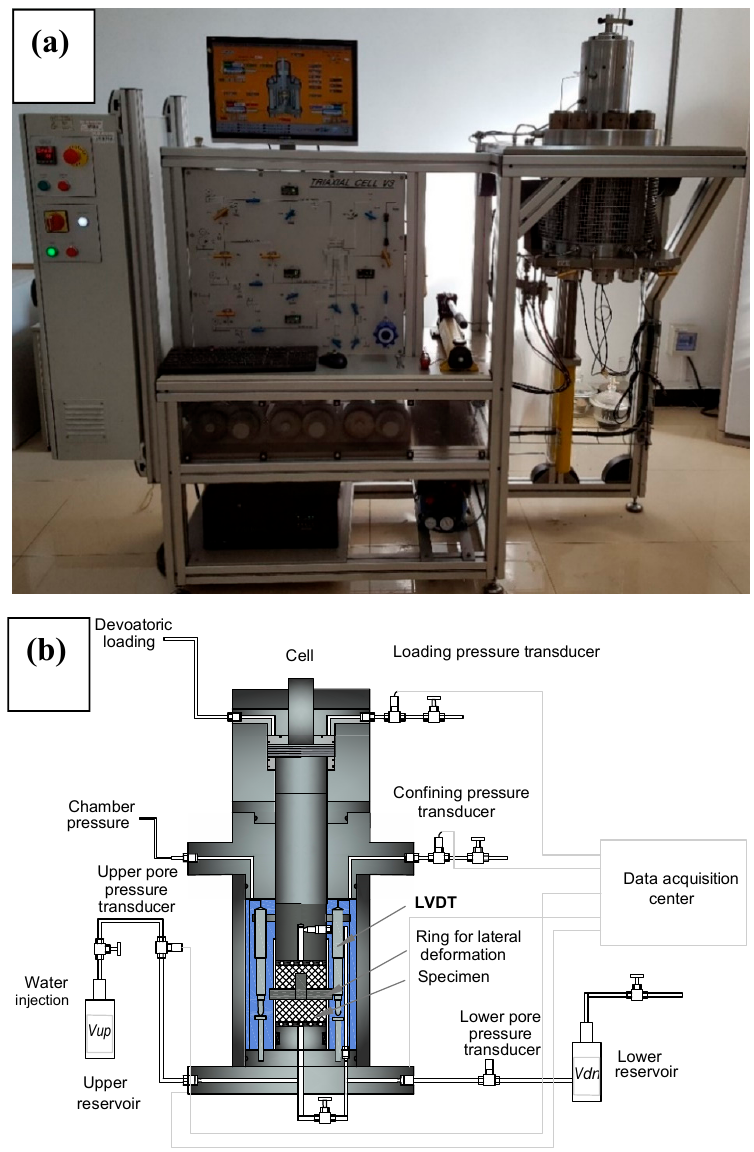
Figure 2. Photo ( a ) and schematic diagram ( b ) of the experimental system.